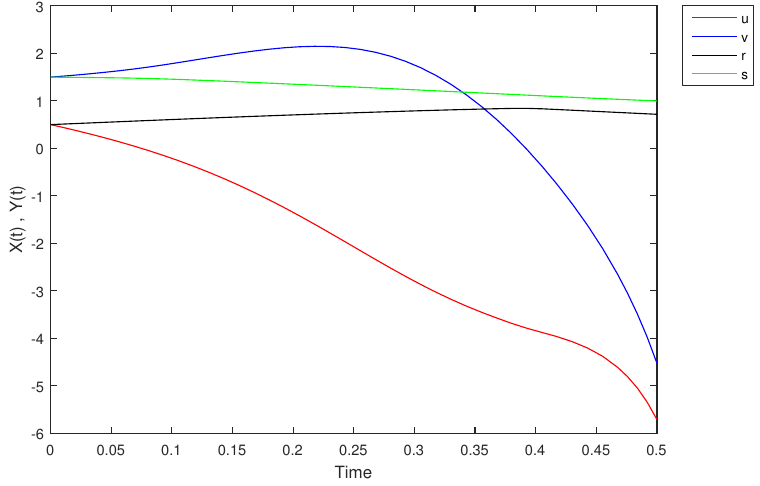
Figure 4. The solution of (5) at α =